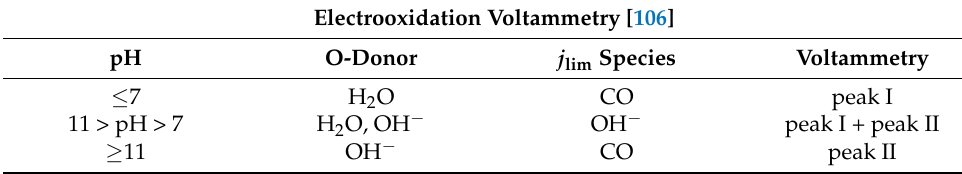
Figure 8. Cyclic voltammetric responses of the Pt UME (10 mm) − tip probe to the products (HCOO) generated at the Au substrate in 0.1 M KHCO 3 ( a ). Tip scan rate: 0.05 V s − 1 . Cyclic voltammetric responses of Pt UME (10 mm)—tip probe to the products (HCOO and CO) generated at Au substrate in 0.1 M KHCO 3 solution saturated with CO 2 ( b ). Adapted with permission from ref. [105]. Copyright 2014 The Royal Society of Chemistry. Schematic representation of the functionalized Au-UME used to measure pH ( c ). Adapted with permission from ref. [106]. Copyright 2020 American Chemical Society. Monitoring corrosion via in situ EC − AFM. EC − AFM scan (527,898 nm 2 ; scale bar, 200 nm). The reported height is relative to a point on the underlying FTO substrate that is resolvable in all EC − AFM images. Common points have been used to align eight subsequent 11 mm 2 scans of the same region, to correct for sample drift and rotation. Three coloured boxes indicate Regions 1 (yellow), 2 (green) and 3 (blue), whose temporal evolution were tracked in detail ( d ). Aligned EC-AFM scans in the three regions indicated in a were used to monitor corrosion-induced changes to BiVO4 mor-phology at 20 min increments in 1M KPi (pH 12.3) ( e ). Adapted with permission from ref. [107]. Copyright 2016 Springer Nature. Table 1. Relationship between pH, j lim species and bulk